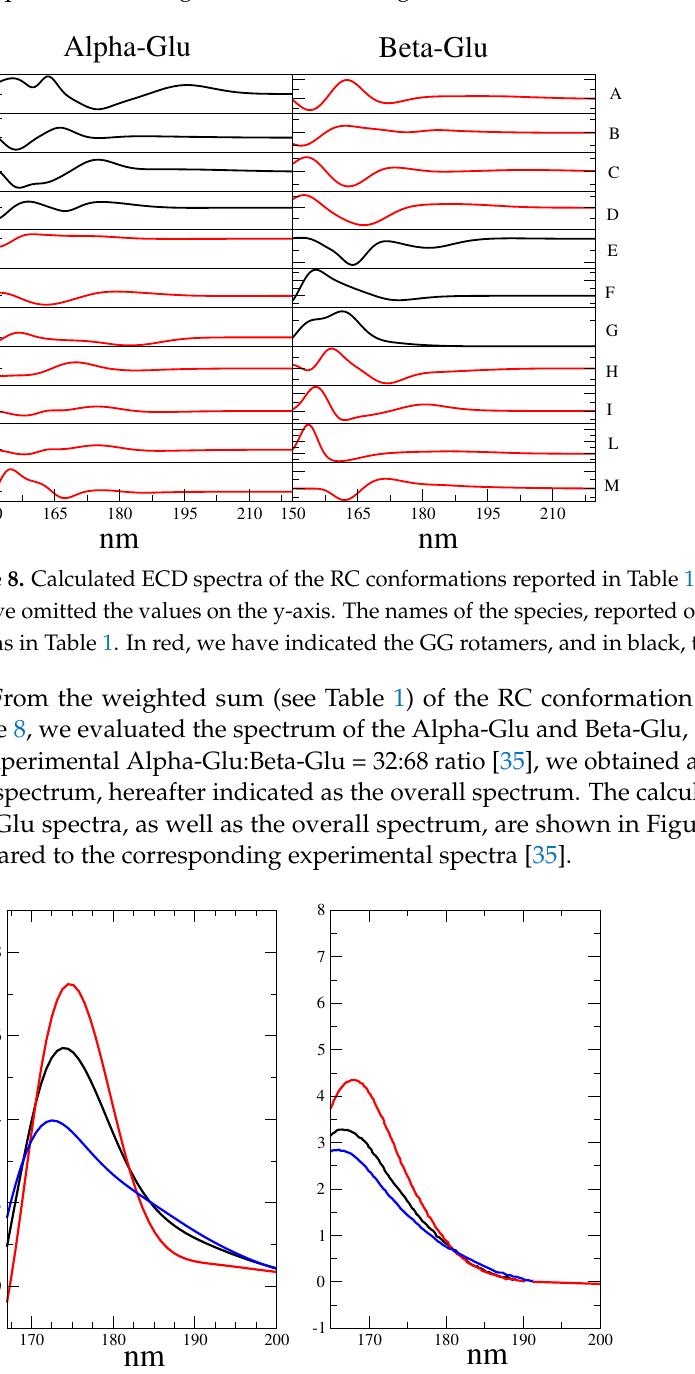
Figure 9. Left side : Calculated ECD spectra of Alpha-Glu (red), Beta-Glu (blue), and the overall spectrum (black), in a water solution. Right side : The experimental spectra [35] of Alpha-Glu (red), Beta-Glu (blue), and the total spectrum (black), in a water